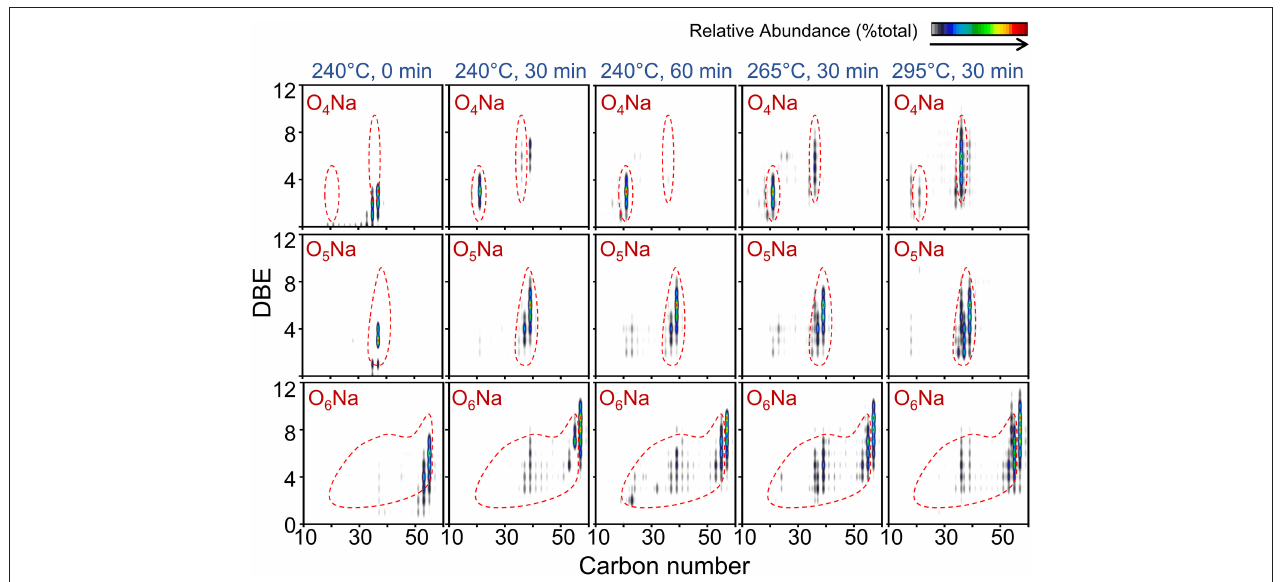
FIGURE 7 | Color-coded isoabundance contour plots for Na-containing heteroatom classes of compounds in bio-crude oil obtained at different HTL temperature and reaction time conditions observed by positive-ion ESI FT-ICR MS.